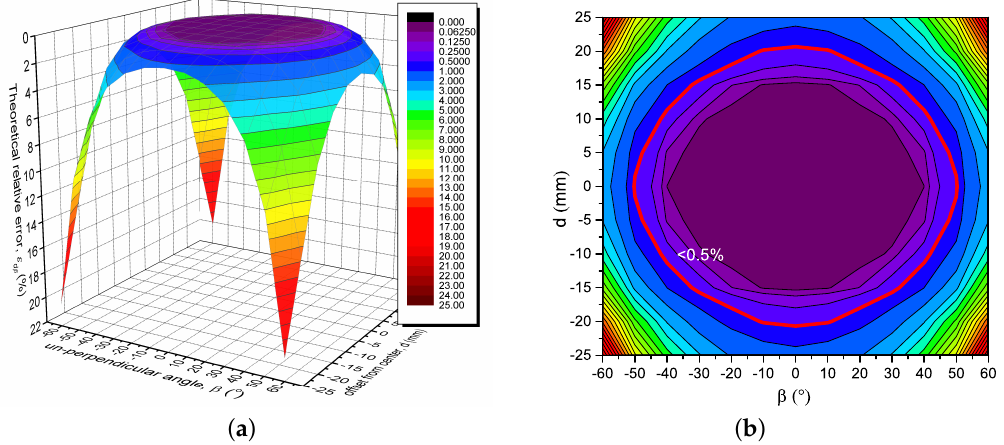
Figure 4. The theoretical relative error depending on d and β , N = 8, α 0 = 0 ◦ . ( a ) 3-D view; ( b ) The contour line, red circle is the contour line of 0.5%. Table 2. Theoretical ε d β with N ranges from 2 to 16, r 0 = 40